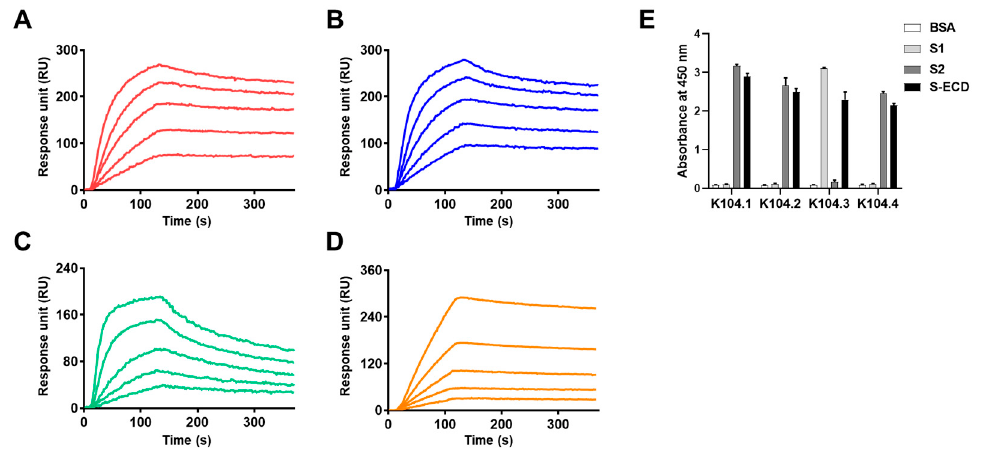
Figure 2. Biochemical analyses of the selected IgG-based mAbs. The binding affinities of the selected mAbs to SARS-CoV-2 S-ECD were analyzed using surface plasmon resonance (SPR) measurements. Each SPR sensorgram shows the interaction between different concentrations (8 nM, 16 nM, 32 nM, 64 nM, and 128 nM) of ( A ) K104.1, ( B ) K104.2, ( C ) K104.3, and ( D ) K104.4 and the SARS-CoV-2 S-ECD-immobilized sensor chip. ( E ) BSA (white bars), S1 (light gray bars) and S2 (dark grey bars) subunits, and S-ECD (black bars) were coated onto microtiter microplates. ELISA was used to measure the molecular specificity of the selected mAbs. Table 1. Evaluation of the binding kinetics of the selected IgG-based mAb to SARS-CoV-2 S-ECD. mAb